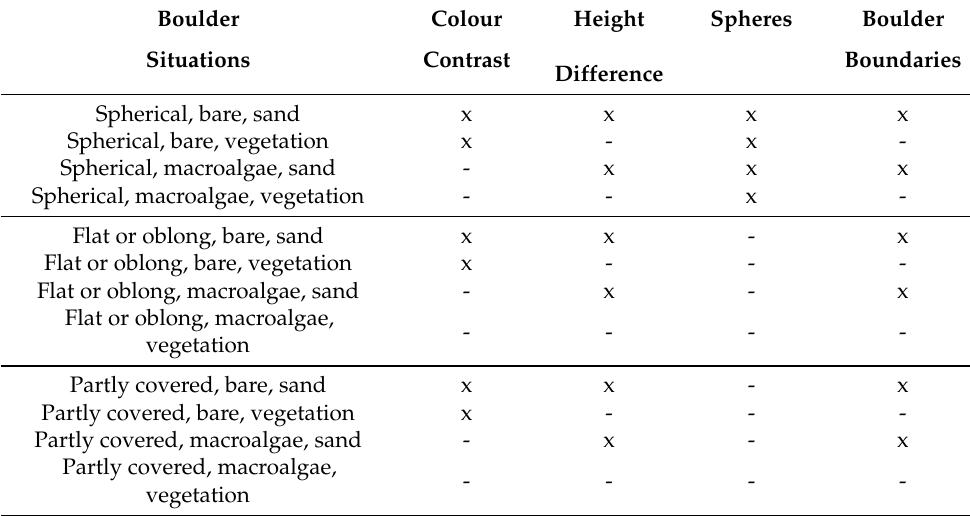
Table 8. Predictor groups in different boulder environments.